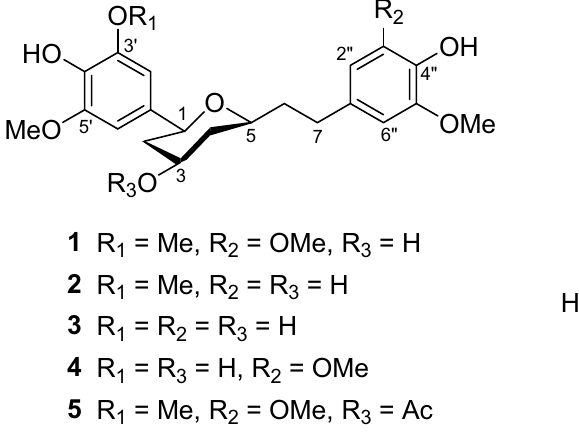
Fig. 1 Structures of coriandralpinins A–G ( 1 – 8 ) Fig. 2 COSY (bold lines) and key HMBC (arrows) and NOESY (dashed arrows) cor- relations of 1 (the 3D conformer represents the DFT global energy